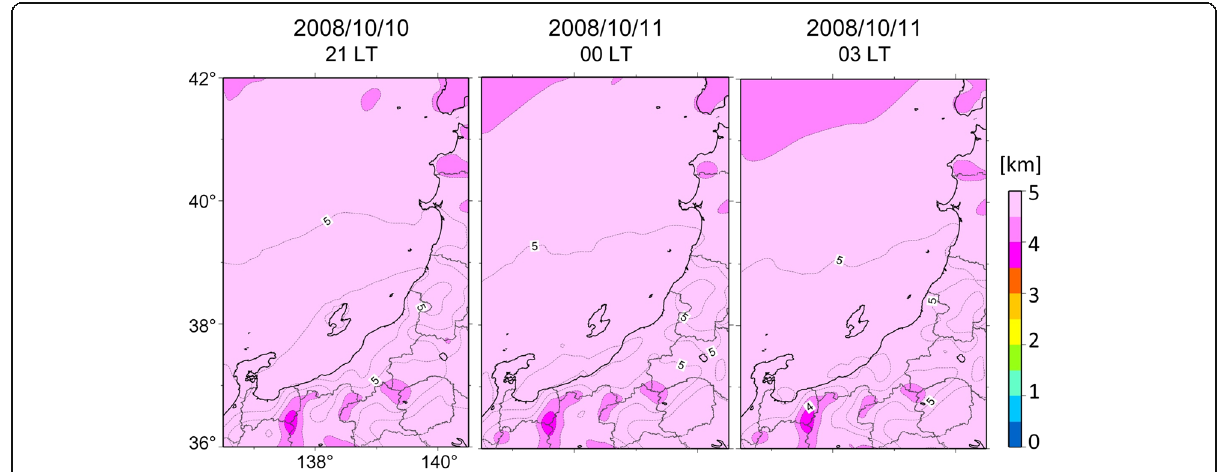
Fig. 12 Distribution of H 10 for case A